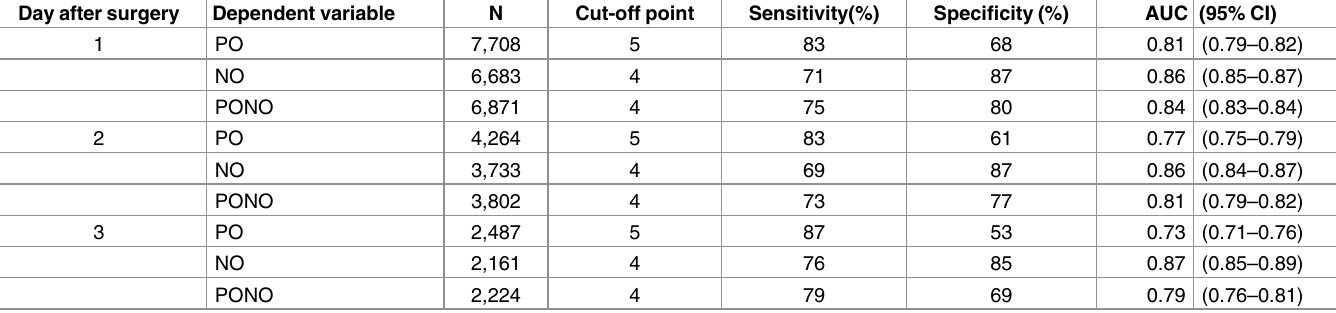
Table 3. Cut-off points obtained from the logistic regression model using the 11-point Numerical Rating Scale for movement-evoked pain as explanatory variable for each of the three dependent variables PO, NO, and PONO. Shown are the optimalcut-off points with their associatedsensitivi- ties and specificities, as well as the areas under the ROC curves (AUC).